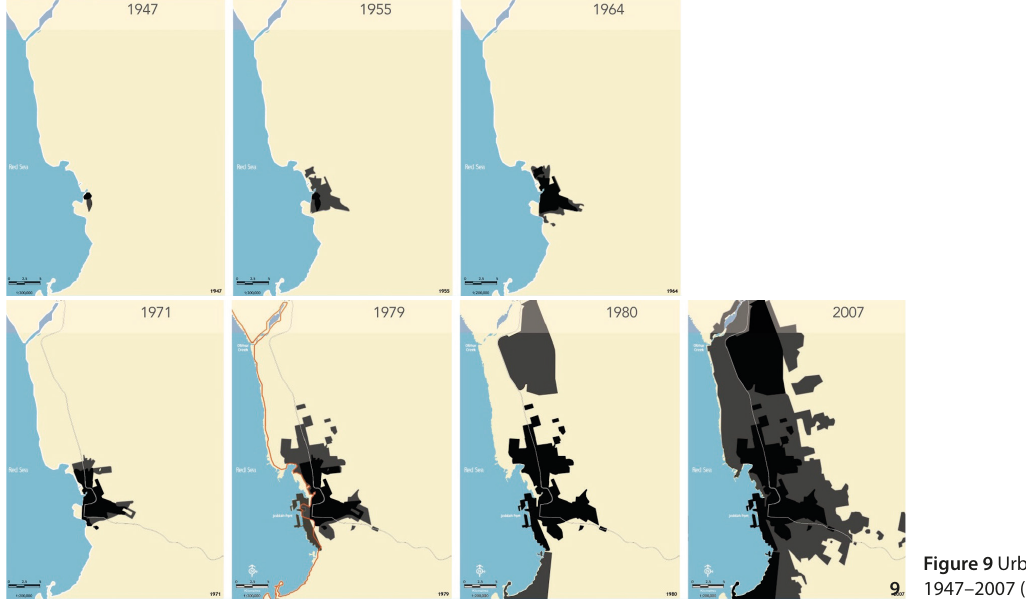
Figure 9 Urban Growth of Jeddah 1947–2007 (Source: RC Heritage).